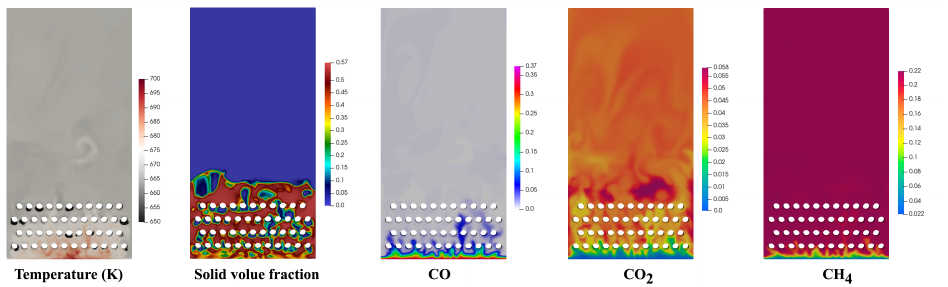
Figure 12. Instantaneous distribution of temperature, solid volume fraction, mass fraction of CO, CO 2 , and CH 4 .